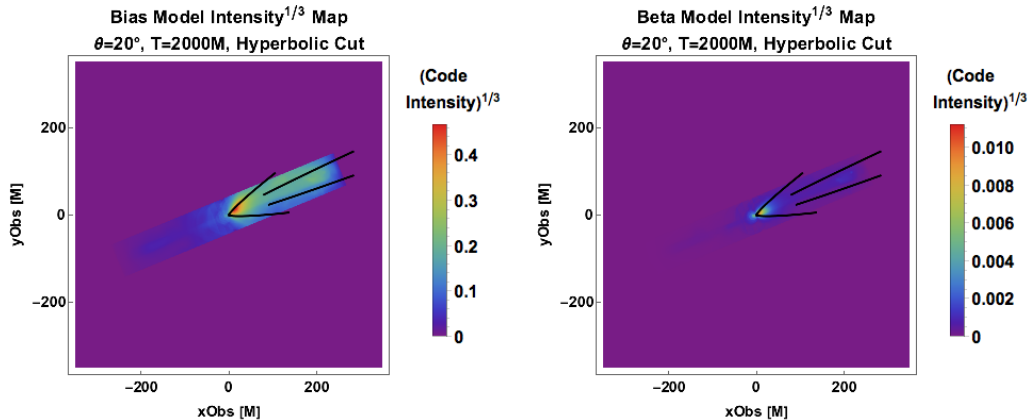
Figure 3. Intensity maps viewed at 20 ◦ observer angle for a simulation where points away from the (cid:0) z (cid:1) 2 < ( region x 2 + y 2 − 40 M ) 2 ∪ ( x 2 + y 2 < ( 40 M ) 2 ∩ | z | > 40 M ) have been excised to isolate the 2 M jets. The N = 0 bias model (left) exhibits a broader and more realistic collimation profile than the β = 1 model (right) compared to the observations (thick black lines). The figures have been transformed by ( · ) 1/3 for visual